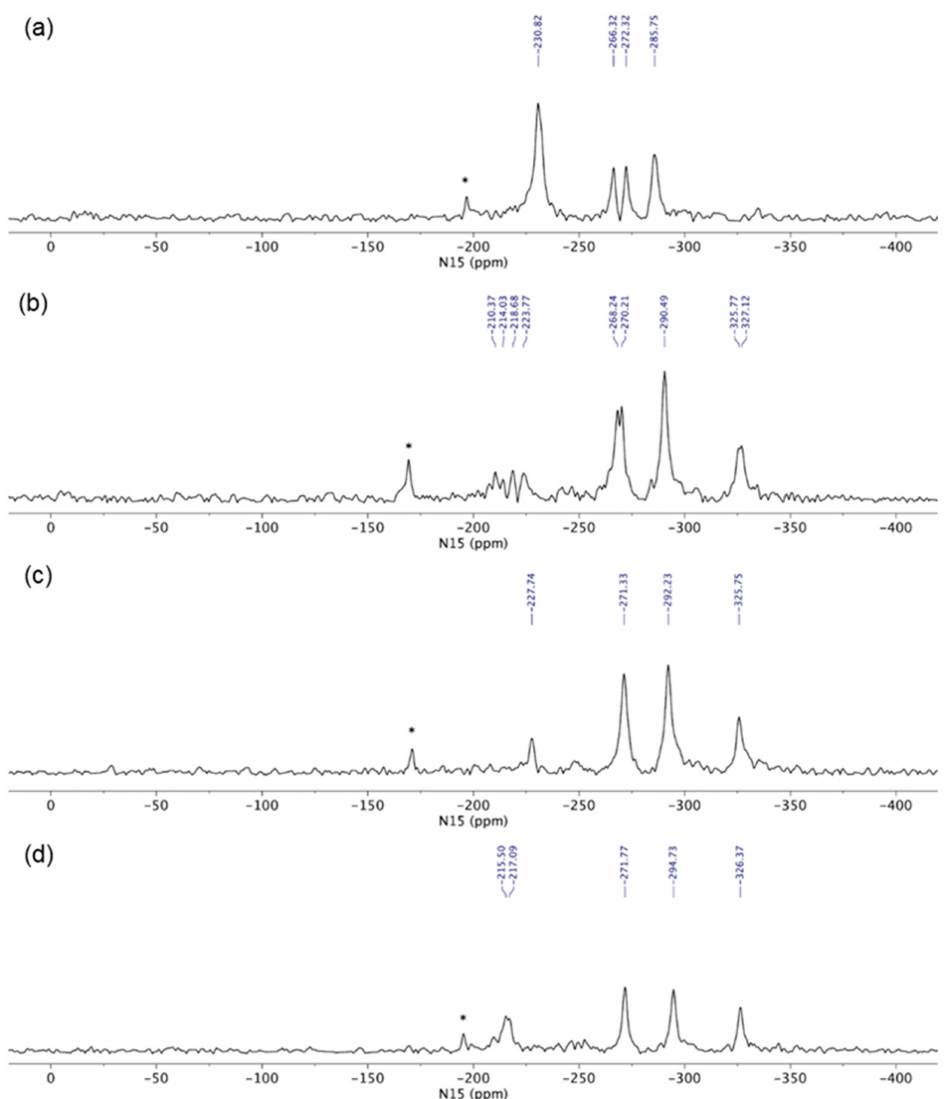
Figure 9. 15 N LG-CP MAS ssNMR ( 15 N Lee–Goldburg cross-polarization magic-angle spinning solid-state nuclear magnetic resonance) spectra of ( a ) glasdegib base, ( b ) glasdegib dihydrochloride, ( c ) glasdegib monomaleate and ( d ) glasdegib dimaleate. Note that signals marked with * were attributed to artefacts that correspond to transmitter-frequency